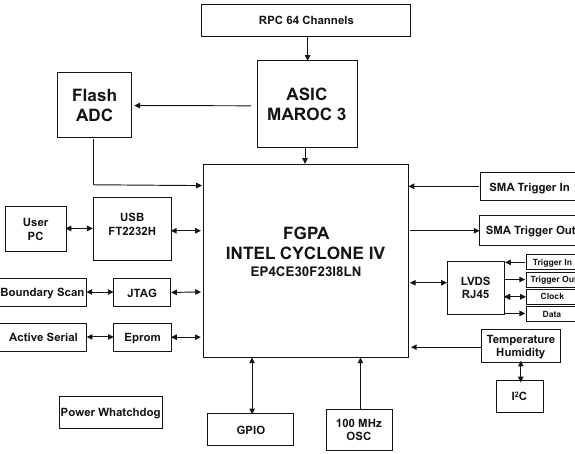
Fig. 3 MARTA DAQ schematic representation with its main compo-